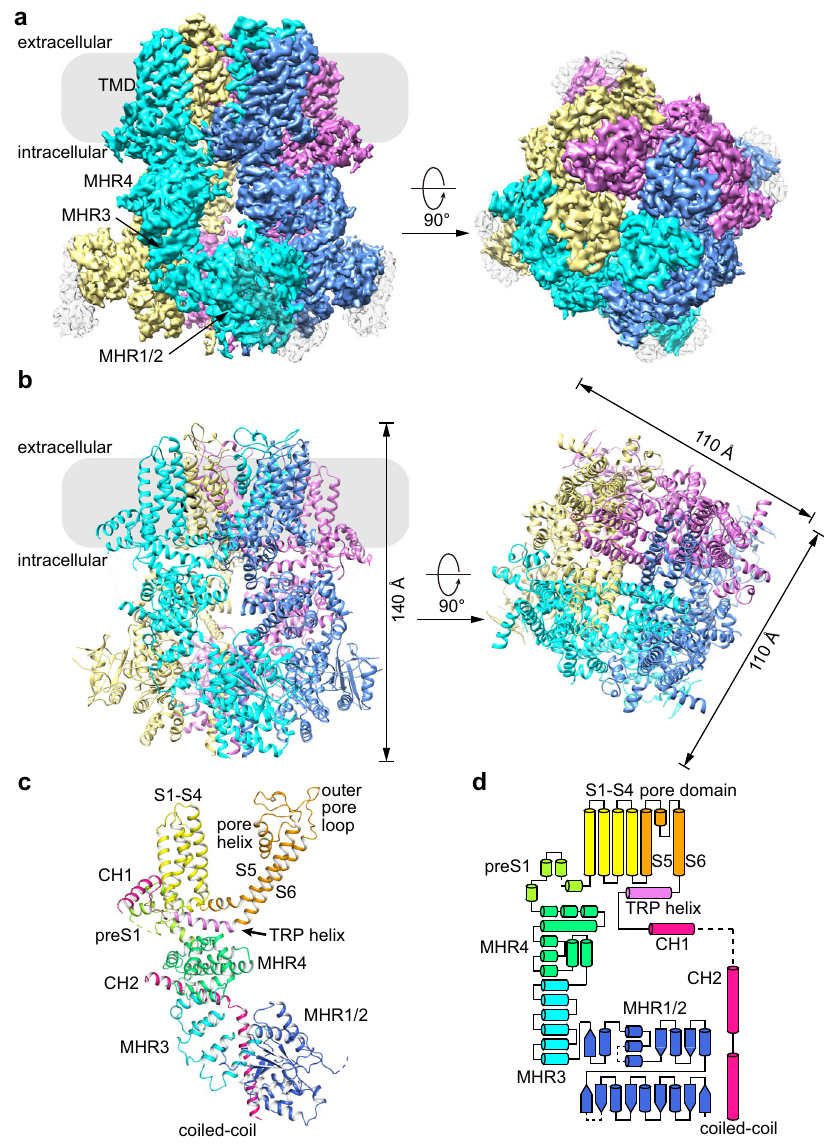
Fig. 2 Overall structure of MmTRPM8 LMNG-ligand-free . a The 3D reconstruction of MmTRPM8 LMNG - ligand-free with each subunit individually colored. b The cartoon representation of MmTRPM8 LMNG - ligand-free with each subunit individually colored. c Cartoon representation of one subunit of MmTRPM8 LMNG - ligand-free with domains colored by the rainbow. d The topology of one MmTRPM8